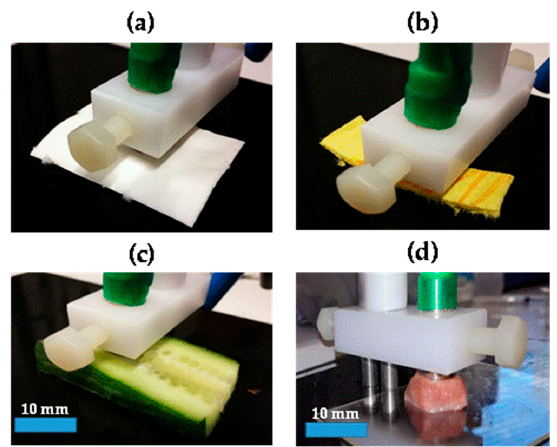
Figure 3. Non-biological samples, i.e., white tissue paper ( a ) and yellow towel ( b ), and biological samples, i.e., cucumber ( c ) and pork tongue ( d ), under testing.